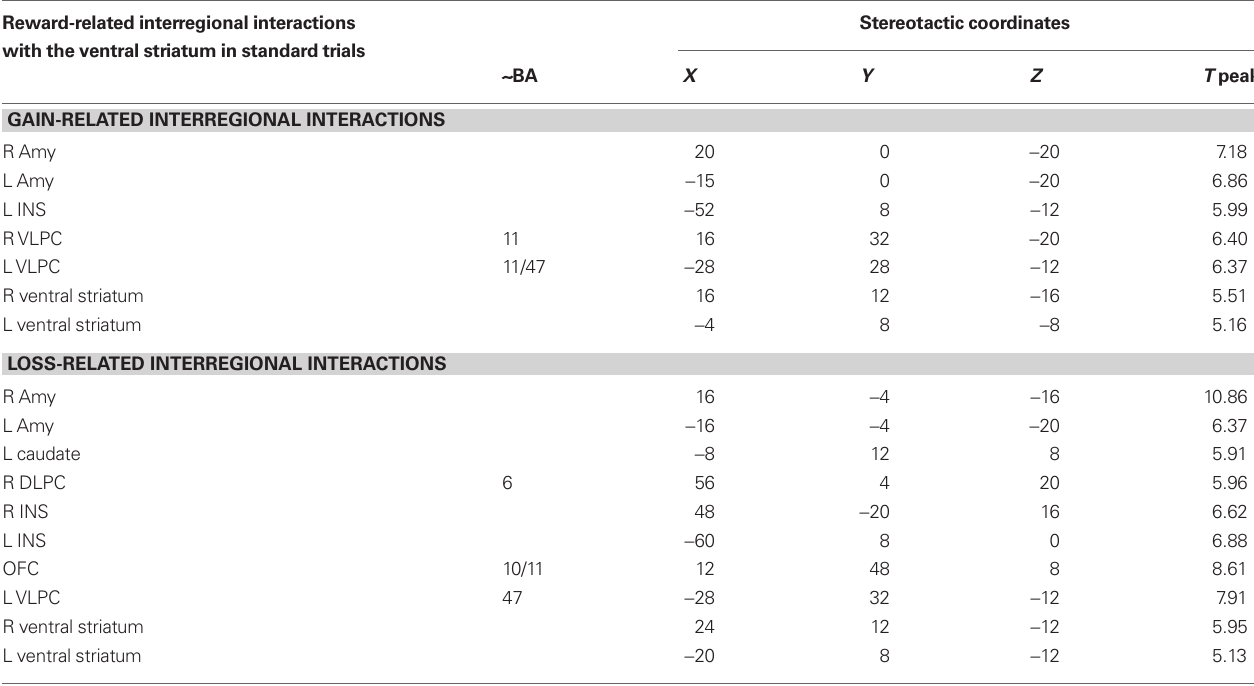
Table 4 | Main effects for valence in the interregional interactions with the ventral striatum in the standard condition. Reward-related interregional